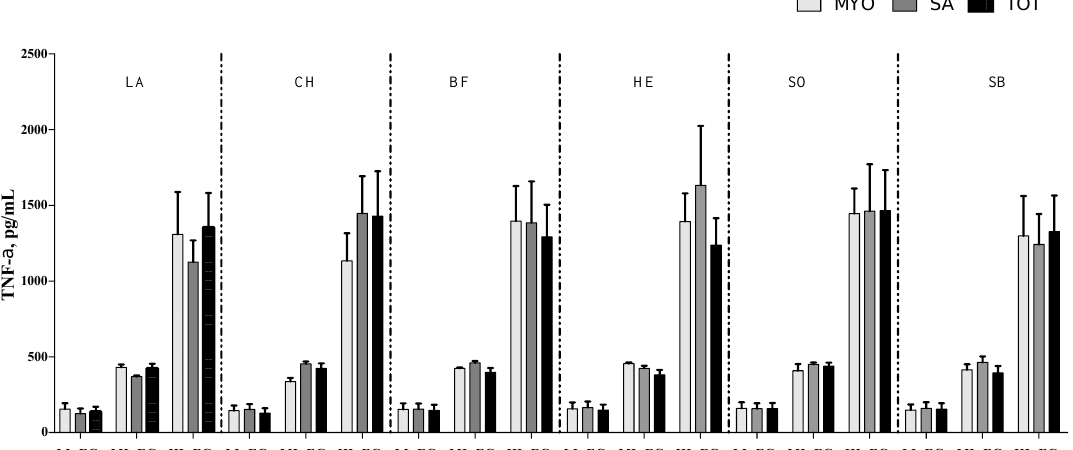
Figure 2. TNF- α secretion (means ± SE; pg/mL) in peripheral blood mononuclear cell supernatants of infants with generalized epilepsy treated in vitro with myofibrillar (MYO, light-grey bar), sarco- plasmic (SA, grey bar), and total protein (TOT, black bar) fractions from beef (BF), lamb (LA), chicken (CH), sole (SO), European hake (EH), and sea bass (SB) sources. LL-EC = group of children with epilepsy with similar levels of cytokines to those of control children; ML-EC = group of children with epilepsy with cytokine levels at least 2-fold higher (medium levels) than those of control children; HL-EC = group of children with epilepsy with cytokine levels at least 8-fold higher (high levels) than those of control children.